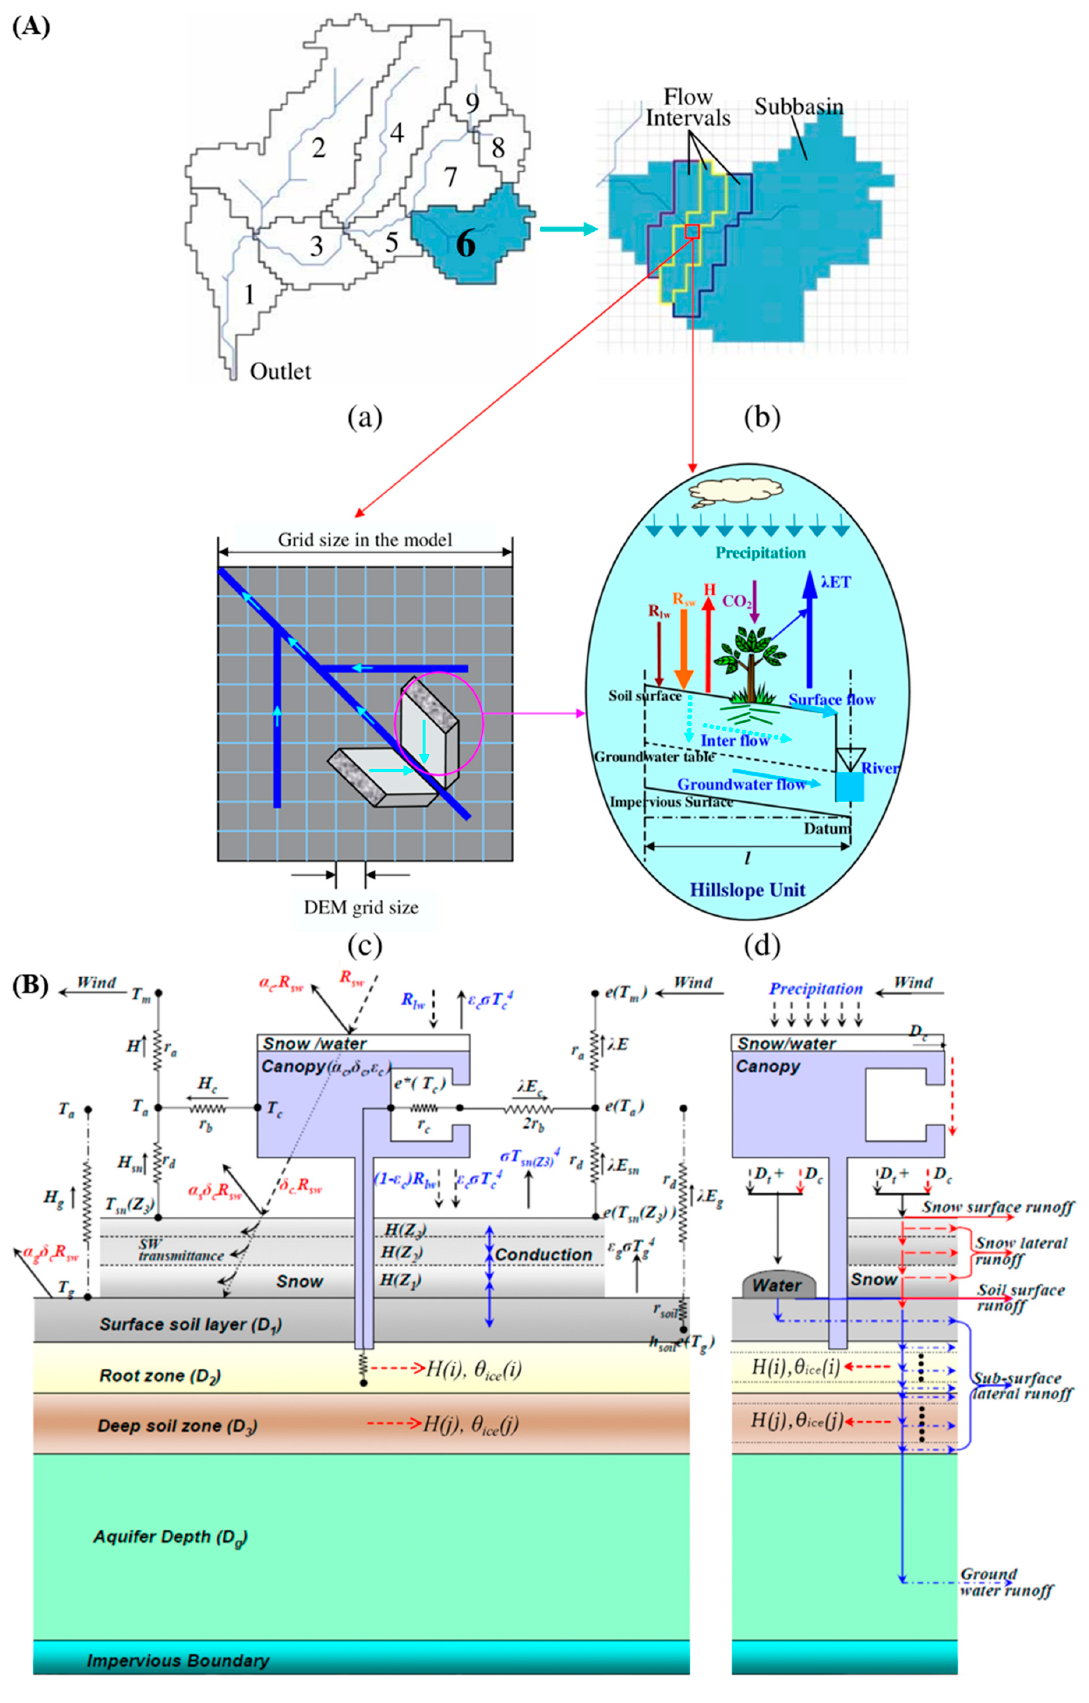
Figure 3. The water and energy budget-based distributed hydrological model (WEB-DHM) structure ( A